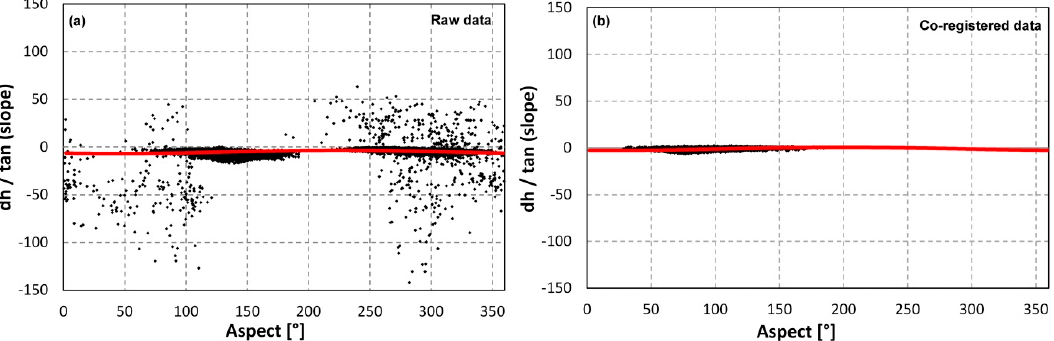
Figure 7. Statistical function for 2014 Pléiades raw data and co-registered data of the Hochjochferner